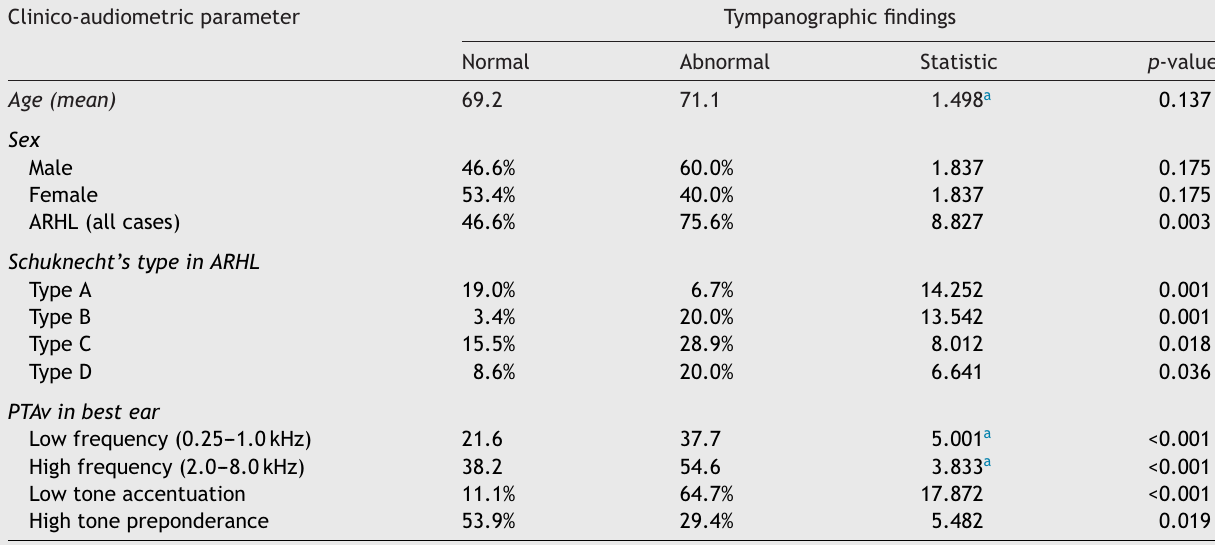
Relationship between clinico-audiometric and tympanographic findings. Clinico-audiometric parameter